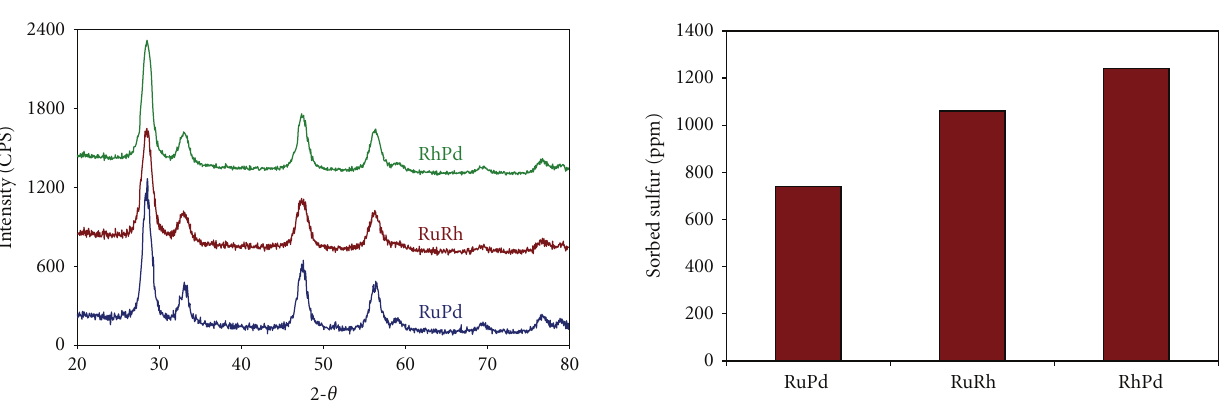
Figure 2: XRD signatures of the bimetal supported catalysts calcined at 700 ◦ C for 2h.